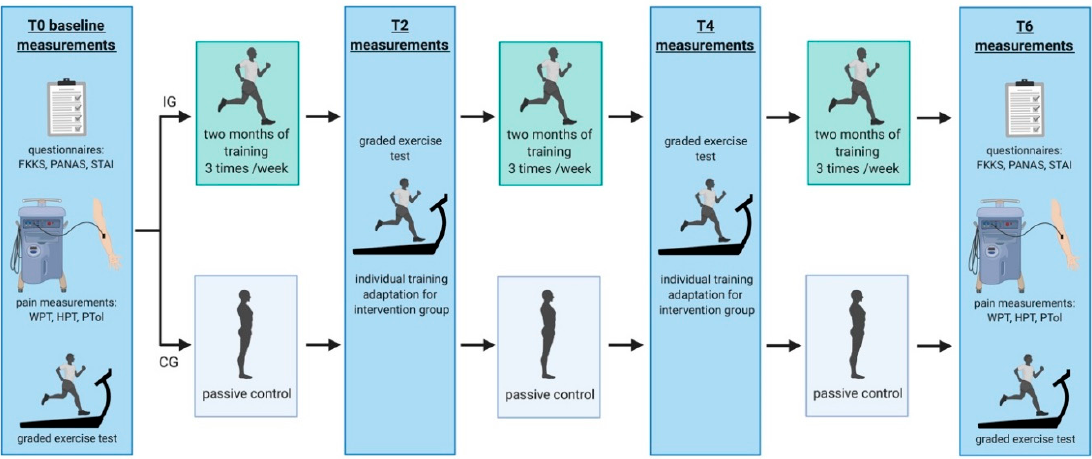
Figure 1. Study design. CG = control group, FKKS = Frankfurt Body-Concept Scales, HPT = heat pain threshold, IG = intervention group, PANAS = Positive and Negative Affect Schedule, PTol = pain tolerance, STAI = State and Trait Anxiety Inventory, WPT = warmth perception threshold.